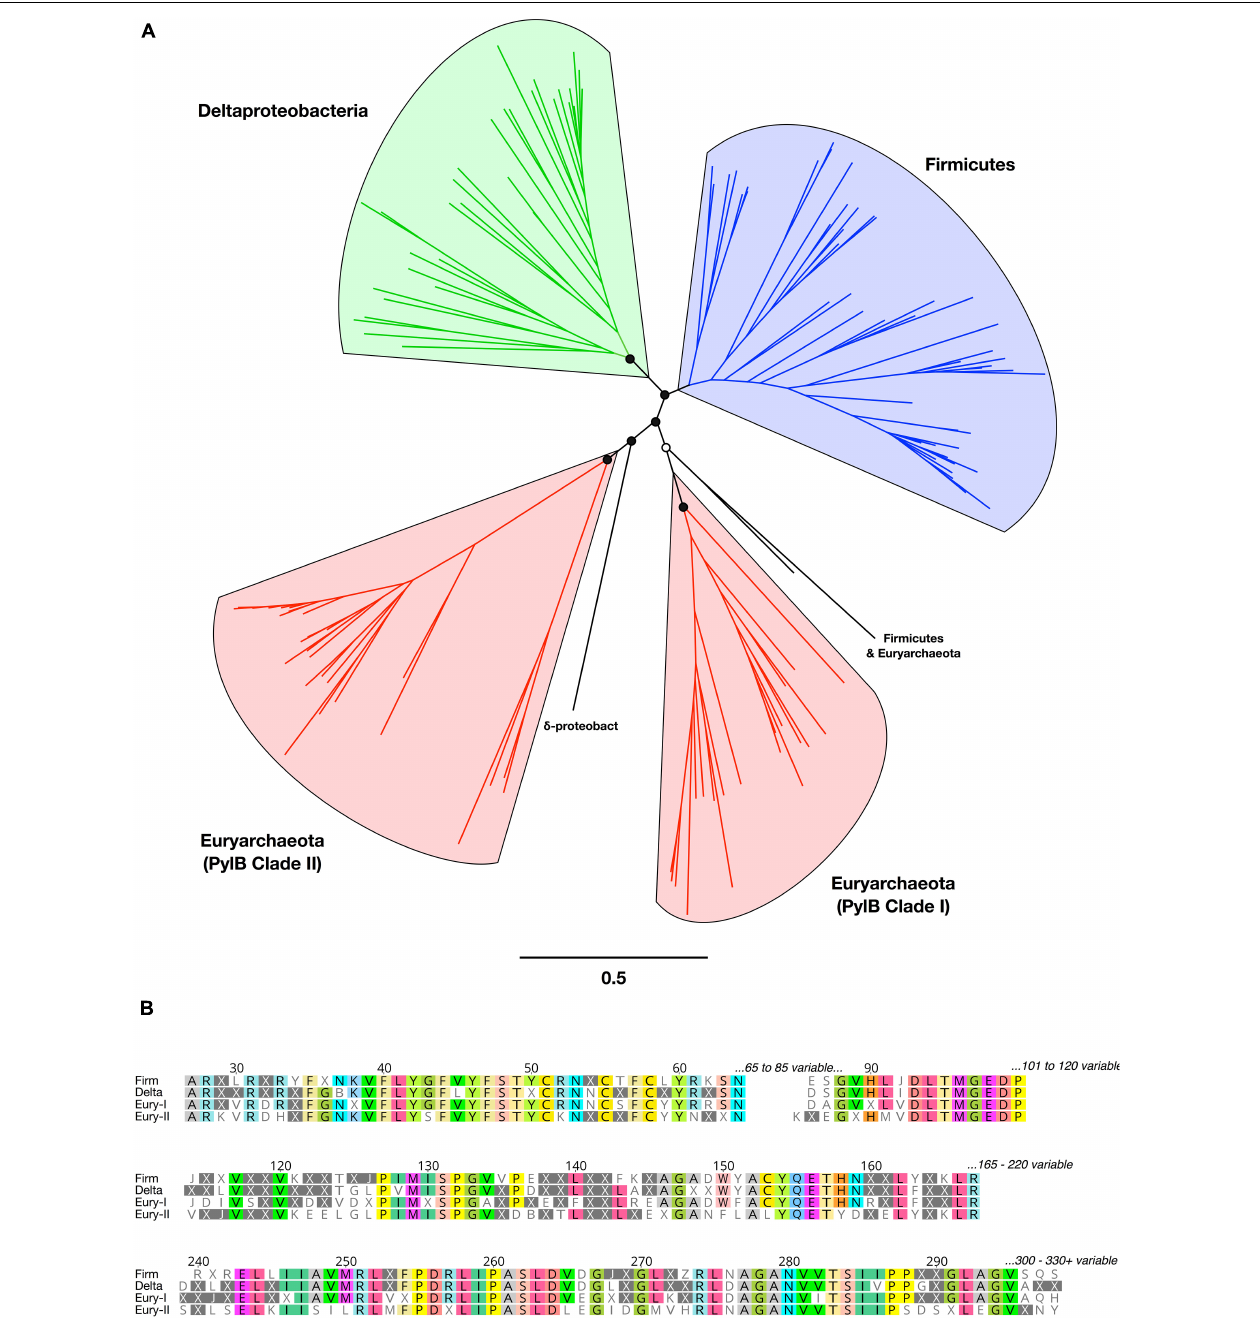
FIGURE 3 | Phylogeny, diversity, and conserved regions of PylB proteins in Bacteria and Archaea. (A) Unrooted phylogenetic tree from PylB sequence alignment. Major clades are highlighted in color by taxonomic classification. Branch support is shown for the basal clades only (open circles > 50%; filled circles > 75%). All tip labels and branch support values are provided in Supplementary Figure 5 . (B) Conserved regions from an alignment of PylB consensus amino acid sequences representing four major clades. A consensus sequence was generated for each of the four PylB clades with a threshold of > 50% identical amino acids found in a clade; positions with < 50% agreement are indicated with “X.” Conserved positions in the alignment are shown and amino acids are highlighted with a > 75% identity